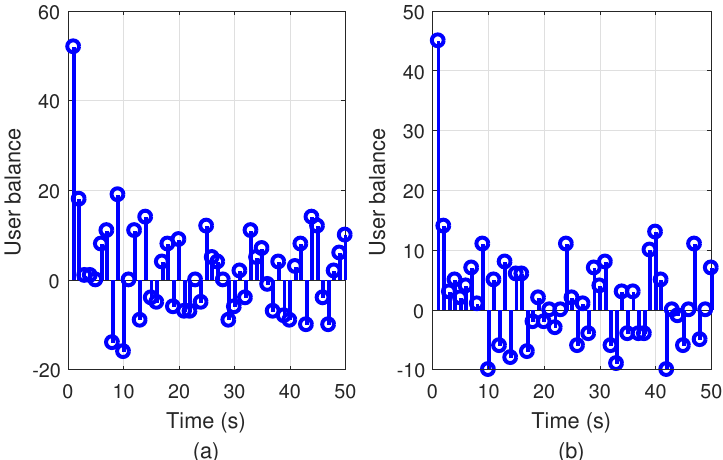
Figure 4. Users forecast for BS #9 in the ( a ) 9-BS network, and ( b ) 37-BS